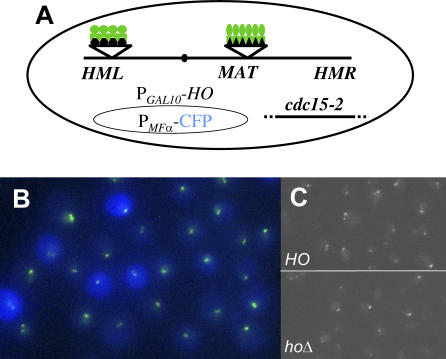
Visualization of Pairing between Donor and Recipient Loci during Mating Type Interconversion in Live Yeast Cells(A) Diagram of yeast cells used in this study, indicating the relevant structure of Chromosome III, which carries arrays of LacO sites at MAT and TetO sites at HML. The strain also constitutively expresses LacI-GFP and TetR-GFP protein fusions and contains a plasmid that carries a galactose-inducible HO gene and CFP under control of an α-cell type–specific promoter.(B) Fluorescence micrograph of a MAT
a strain, Y3343, freshly transformed with plasmid B2609, 6 h after induction of HO. Green dots mark HML and MAT loci in each cell, and uniform blue staining indicates that the cell has undergone a mating type switch to MATα. Cells are demarked by the diffuse cyan fluorescence, and the diffuse yellow fluorescence defines the nuclei.(C) Deconvolved and compressed images showing GFP foci in isogenic strains carrying or lacking PGAL1-HO, taken 90 min following induction with galactose.